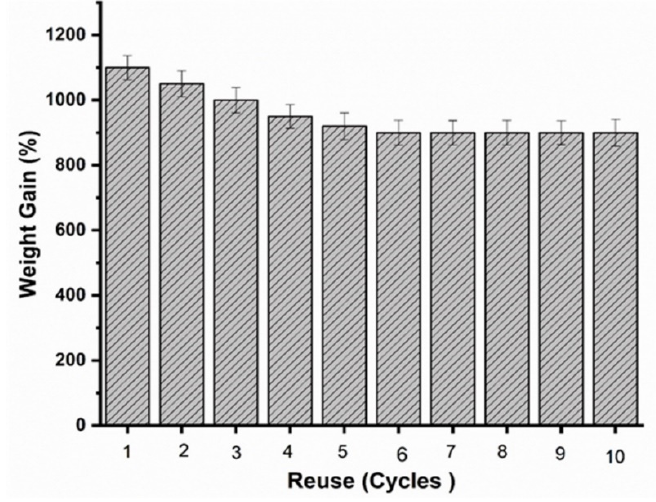
Figure 12. Photographs of the sorption process of soybean oil by sponge PP10L-0.3 P.